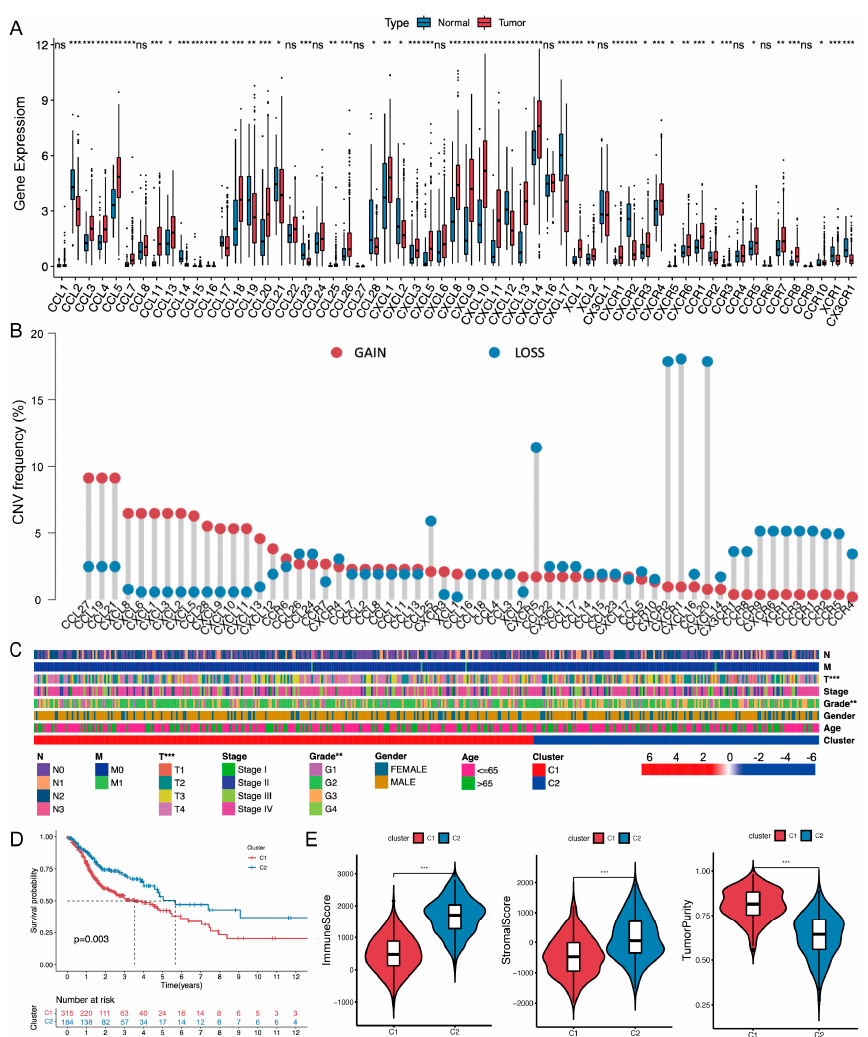
Figure 2. Identification of chemokine/chemokine receptor clusters in the TCGA-HNSCC cohort. ( A ) The expression level of C/CR genes between normal and HNSCC tissues. ( B ) CNV frequencies of C/CR genes in the TCGA-HNSCC cohort. ( C ) Different clinicopathological features between the two clusters. ( D ) Kaplan–Meier survival analysis of the two clusters. ( E ) Immune score, stromal score, and tumor purity of the two clusters. ns, p > 0.05, * p < 0.05, ** p < 0.01, *** p < 0.001.